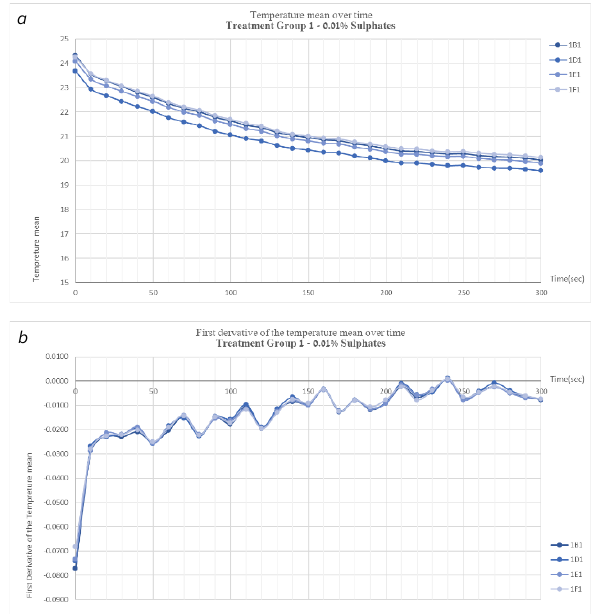
Figure 9. (a) temperature mean over time and (b) first derivative of the temperature mean over time.